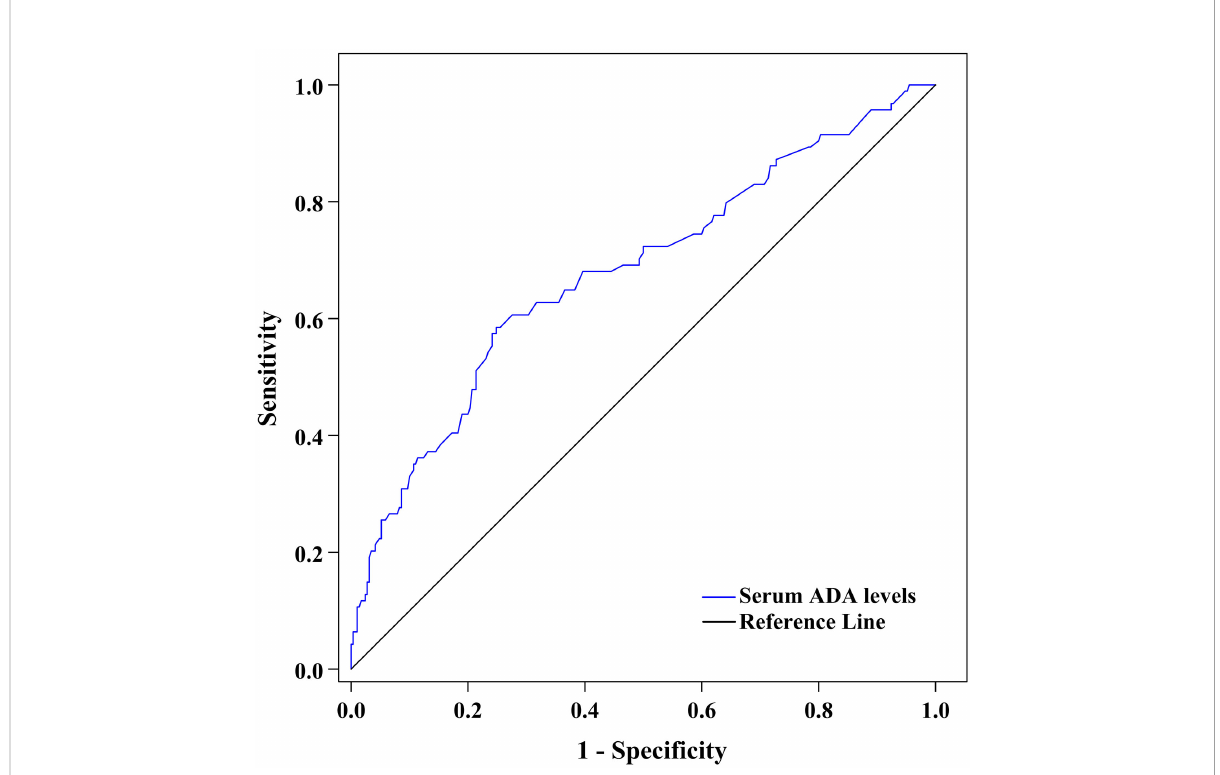
FIGURE 4 ROC curve exhibiting the capability of serum ADA levels to discriminate DPN (AUC was 0.685 [95% CI: 0.636 – 0.731], optimal cut-off value was ≥ 14.2 U/L, Youden index was 0.351, sensitivity was 59.57%, and speci fi city was